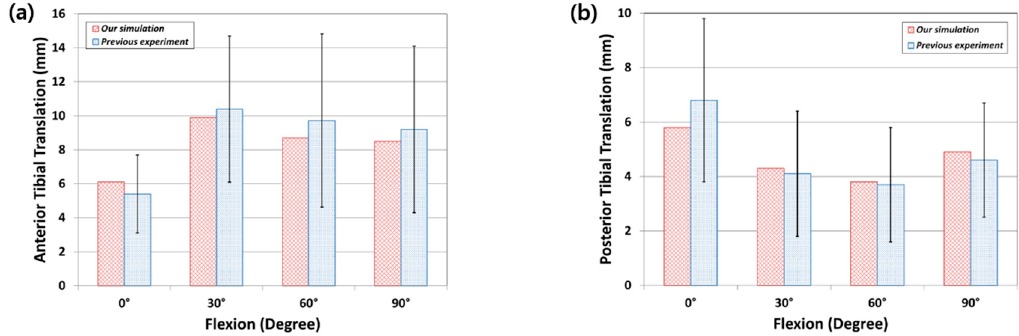
Figure 4. Comparison with previous experimental study for validation of unicompartmental knee replacement (UKR) model: ( a ) anterior tibial translation; and, ( b ) posterior tibial translation.